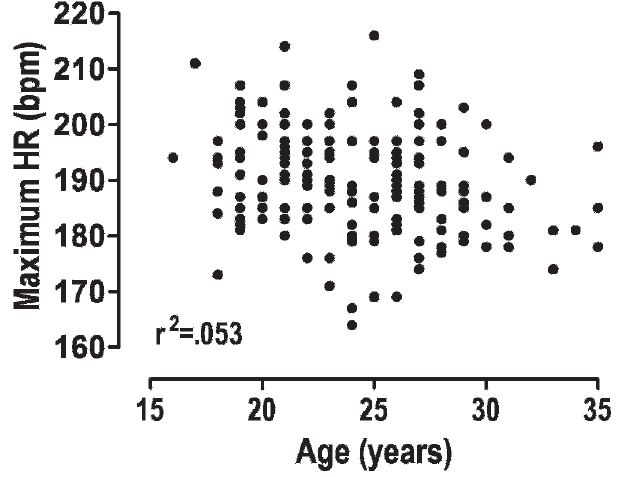
Figure 3 - Relationship between maximum heart rate (HR) values and age in a sample of 180 professional